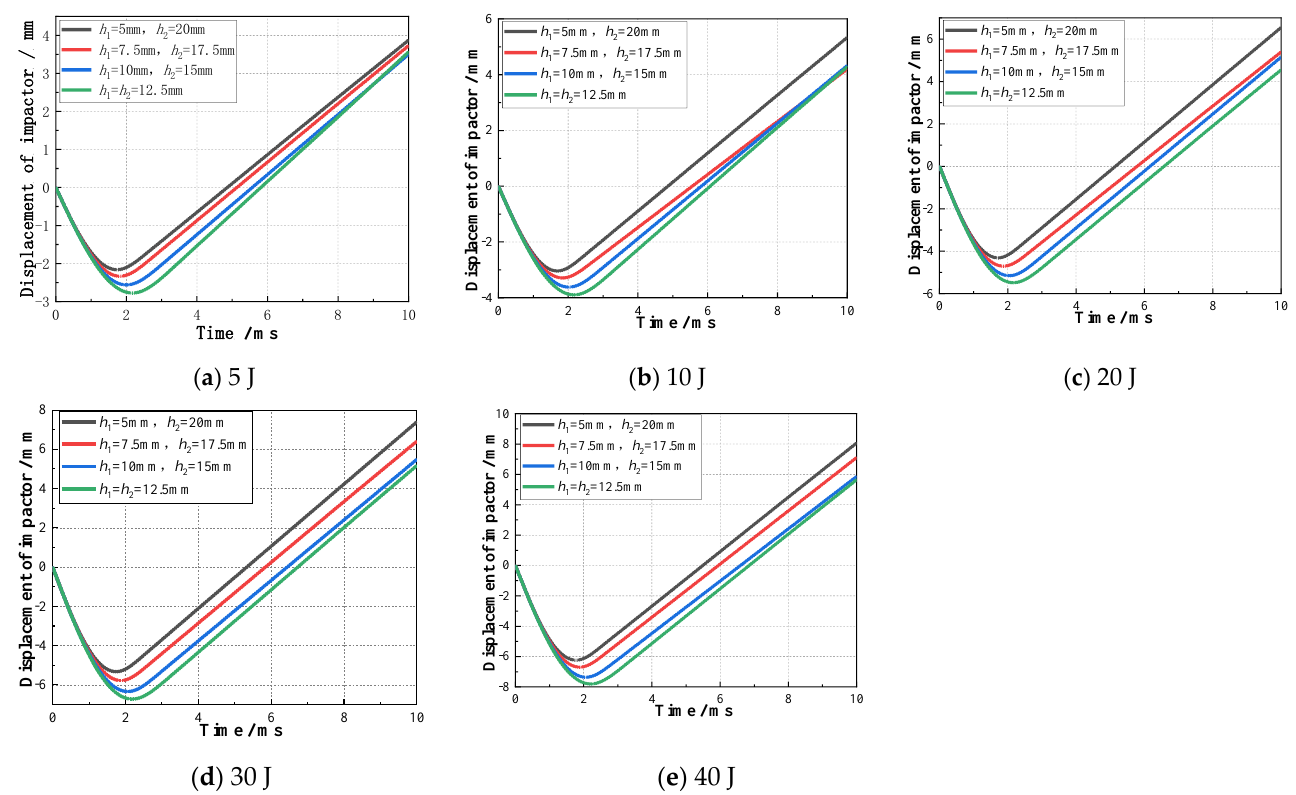
Figure 12. Displacement − Time curve of impactor of double − layer structures with different core heights under different impact energies.